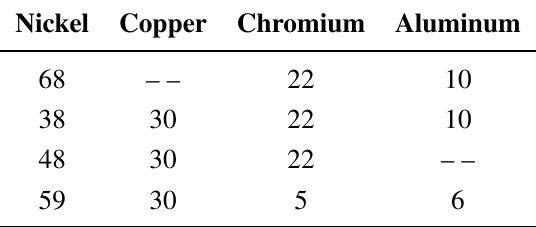
Table 1. Compositions of the alloys investigated in this work (in wt%). Nickel